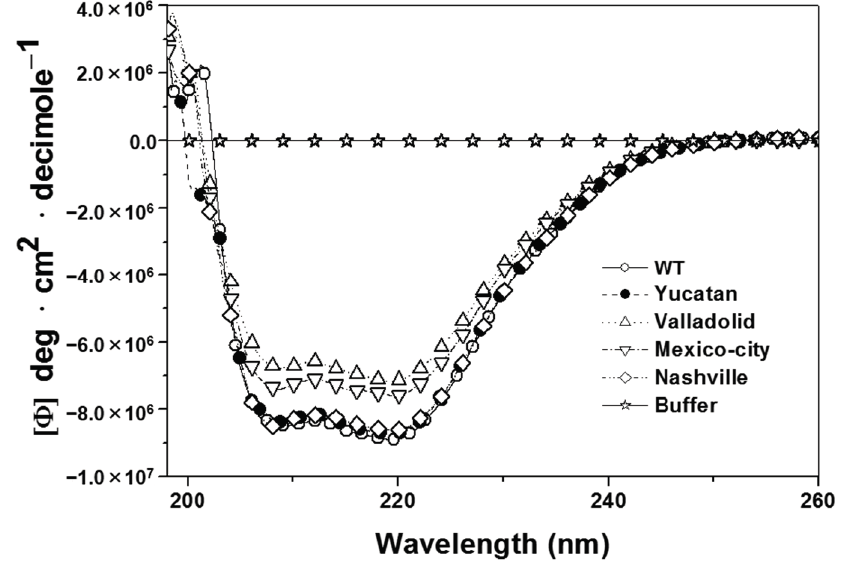
Figure 3. Structural characterization of human recombinant wild-type (WT) G6PD and mutants. Far-UV circular dichroism (CD) spectra of WT G6PD and mutants are shown. The protein concentration was 0.8 mg/mL in all cases. The experiments were performed in duplicate; standard errors were less than